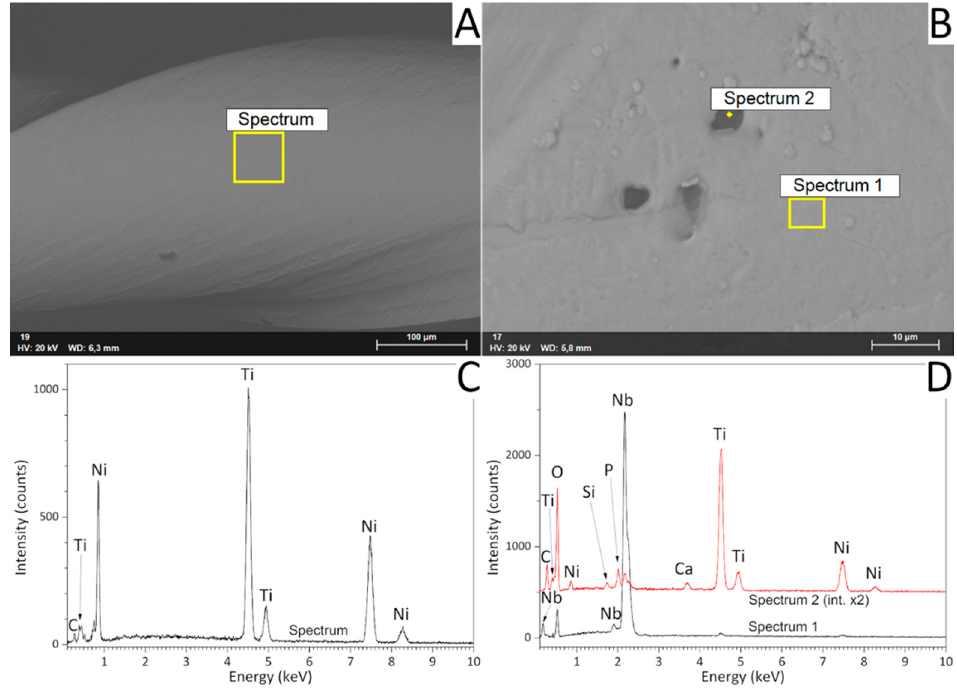
Figure 3. Backscattered electron SEM micrographs ( A , B ) and corresponding energy-dispersive X-ray (EDX) spectra ( C , D ) acquired on the working area of the Reziflow ( A , C ) and Procodile ( B , D ) instruments.